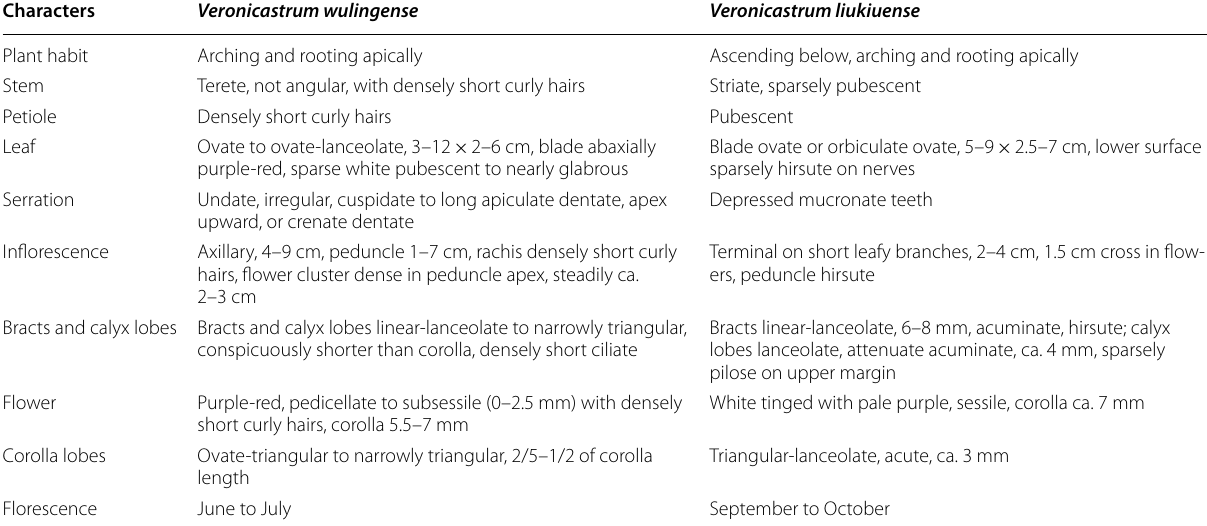
Table 1 Morphological comparison of the diagnostic characteristics between Veronicastrum wulingense and V. liukiuense